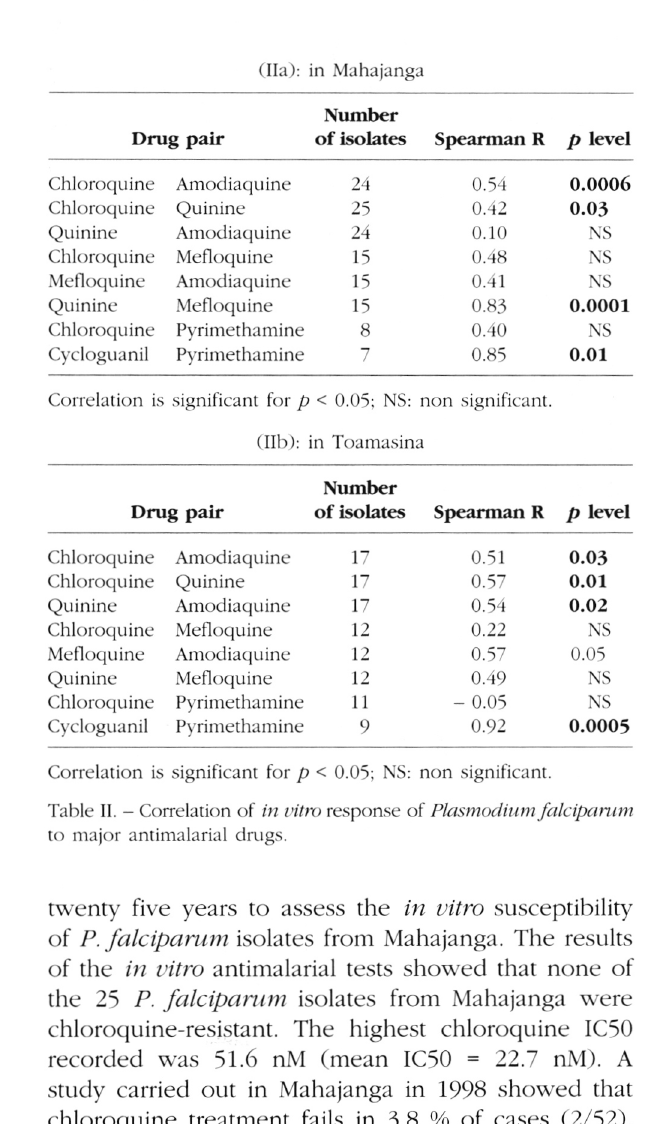
twenty five years to assess the in vitro susceptibility of P. falciparu m isolates from Mahajanga. The results of the in vitro antimalarial tests showed that none of the 25 P. falciparu m isolates from Mahajanga were chloroquine-resistant. The highest chloroquine